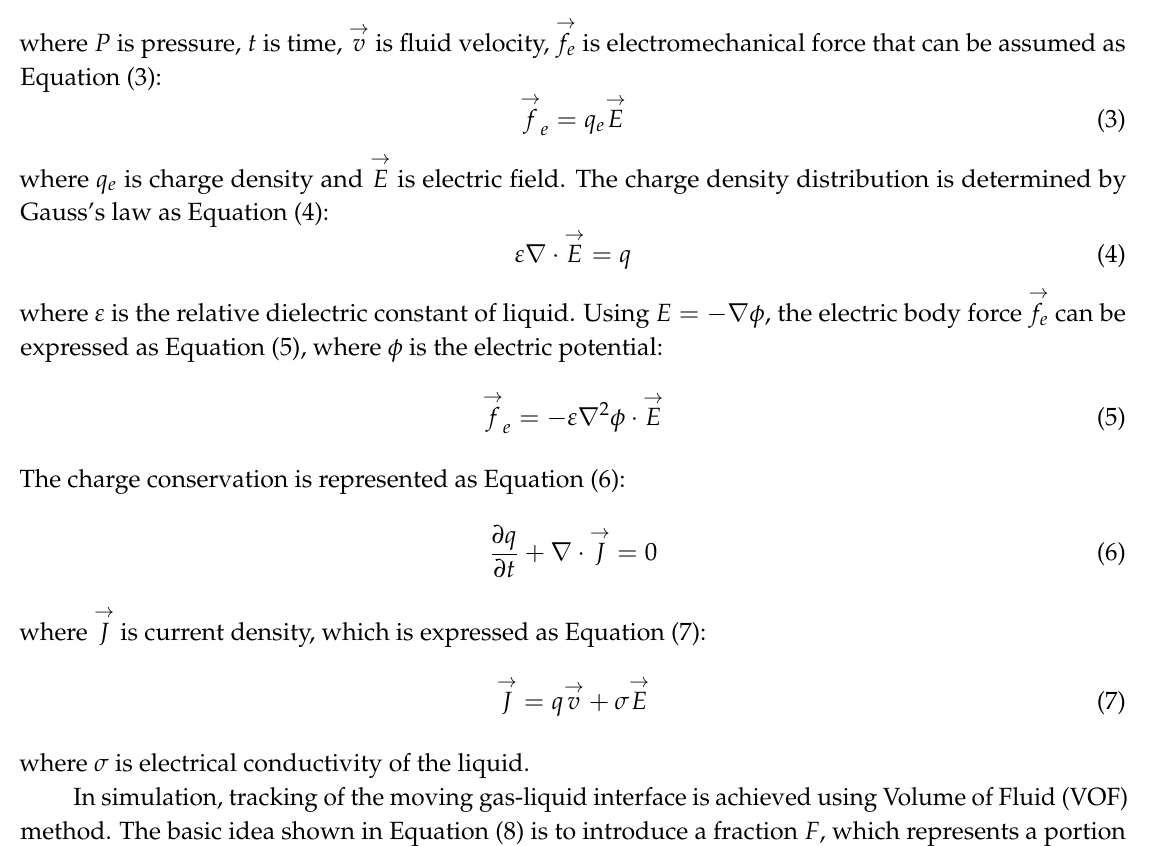
Figure 2. ( a ) Schematic diagram of nozzle-substrate structure, ( b ) schematic diagram of the three- phase calculation model in simulation.